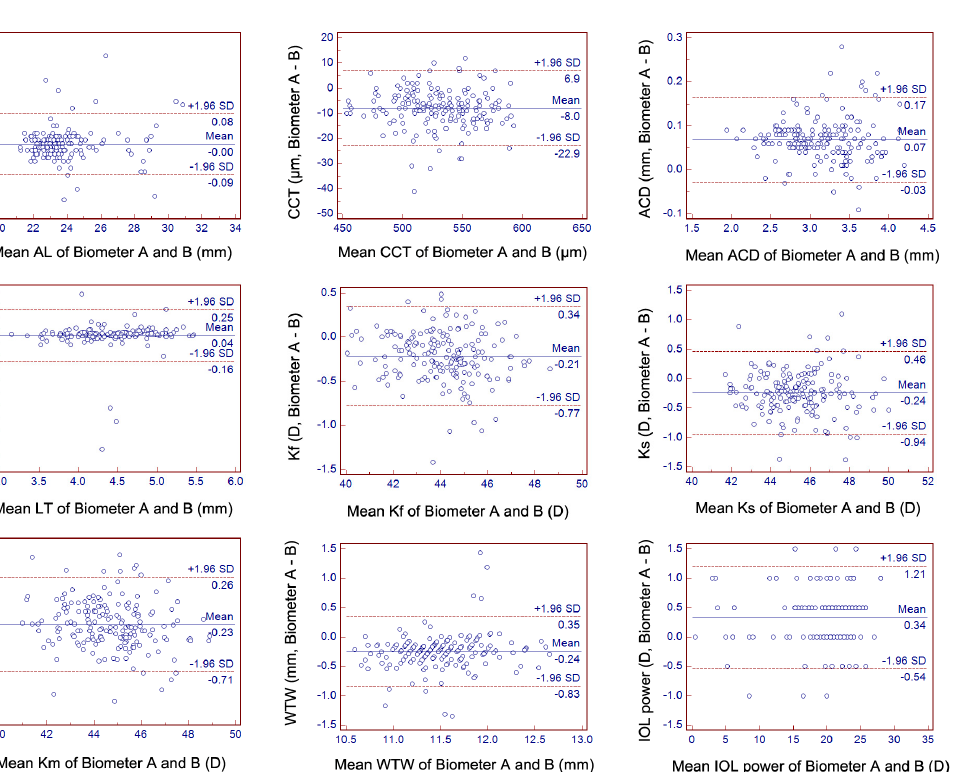
Note: ACD = anterior chamber depth; AL = axial length; CCT = central corneal thickness; D = diop- ter; IOL = intraocular lens; Kf = flat keratometry; Ks = steep keratometry; Km = mean keratometry; LT = lens thickness; x = ANTERION; y = IOLMaster 700; WTW = white-to-white. The mean IOL power difference was about 0.34 D between the two devices with the online Barrett calculator (Table 2, p < 0.001). In total, 62 (34.6%) eyes showed no difference in IOL power calculation. However, approximately 65.4% (117 eyes) of the eyes demon- strated ≥ 0.5 D difference in IOL power between the two biometers. 4. Discussion In our study, the major findings were as follows: (1) Both two biometers provided a comparable AL acquired rate for patients with cataract, and (2) based on the vector anal-